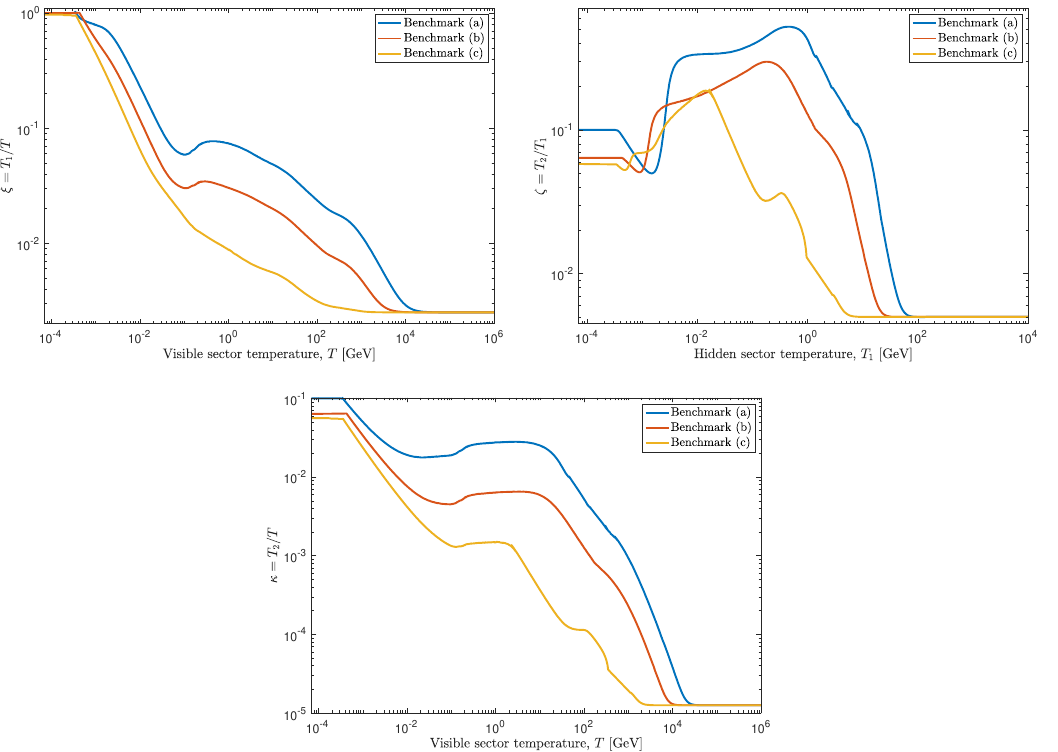
Figure 4 . Evolution of ξ (upper panel) and κ (bottom panel) as a function of the visible sector temperature T and that of ζ (middle panel) as a function of T 1 for three benchmarks (a), (b) and (c) of table